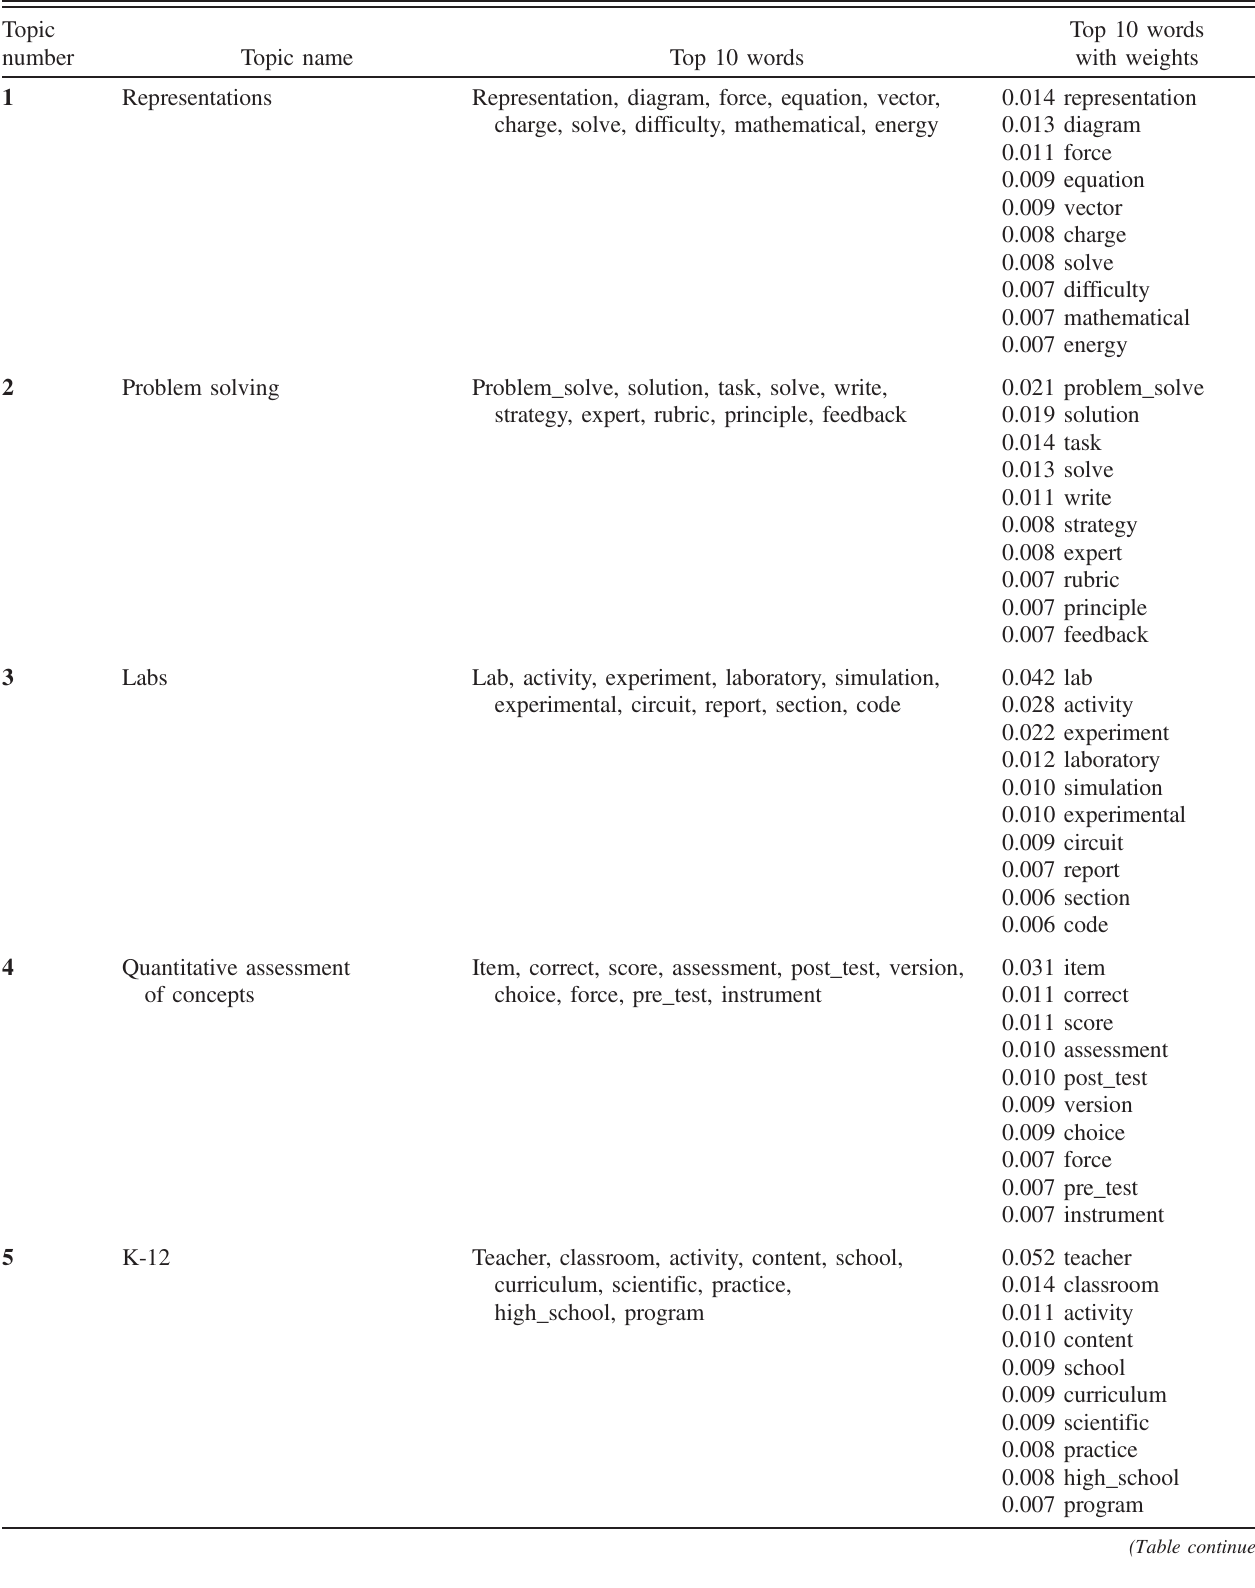
TABLE I. Topic numbers, names, top 10 words, and top words with weights.